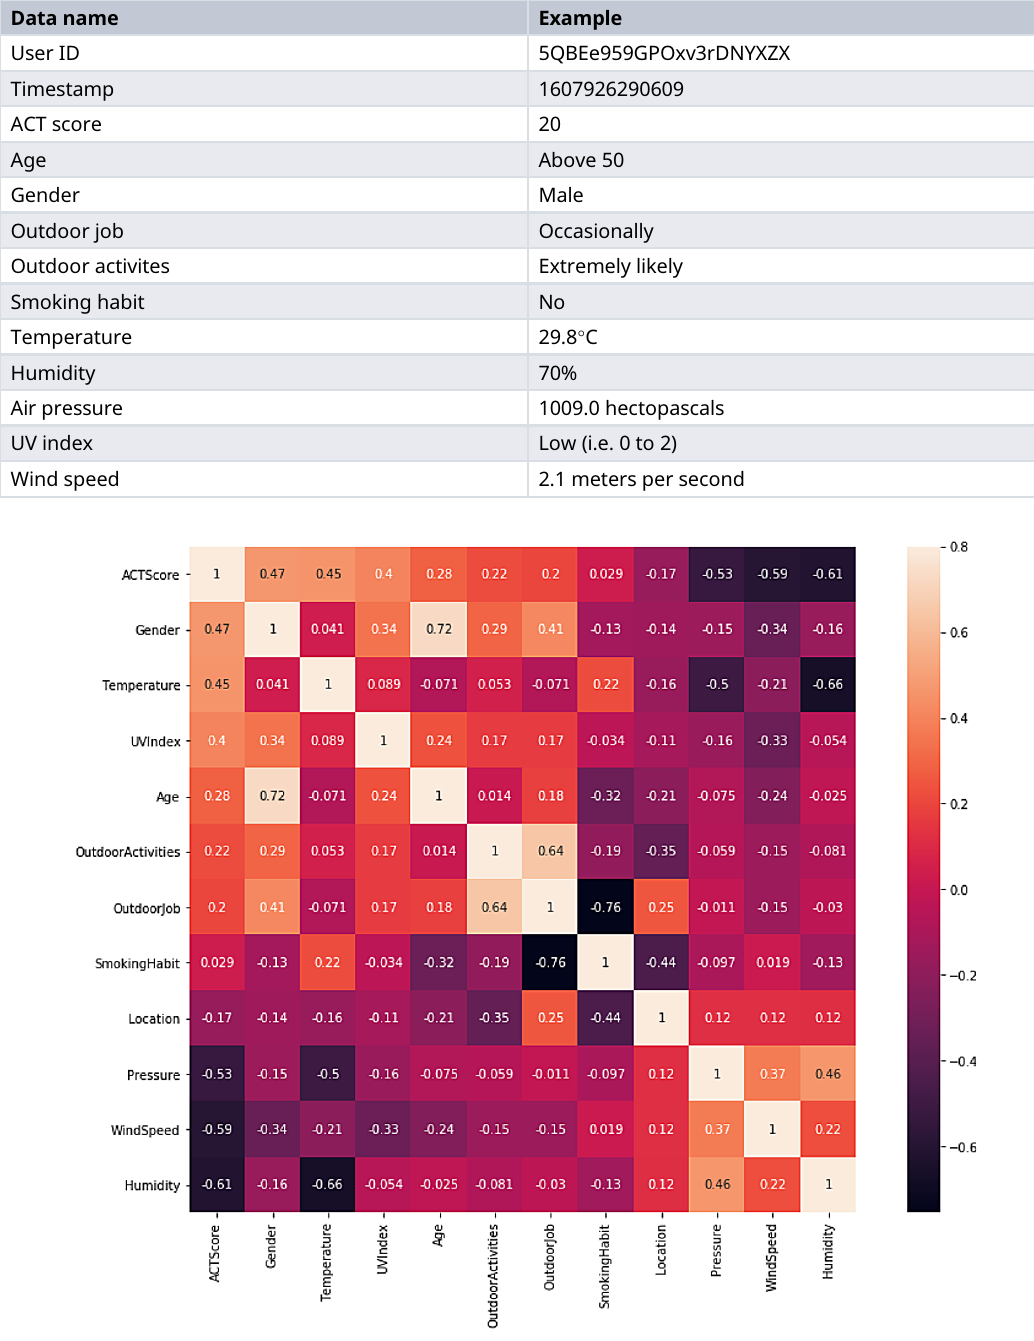
Figure 1. Heatmap